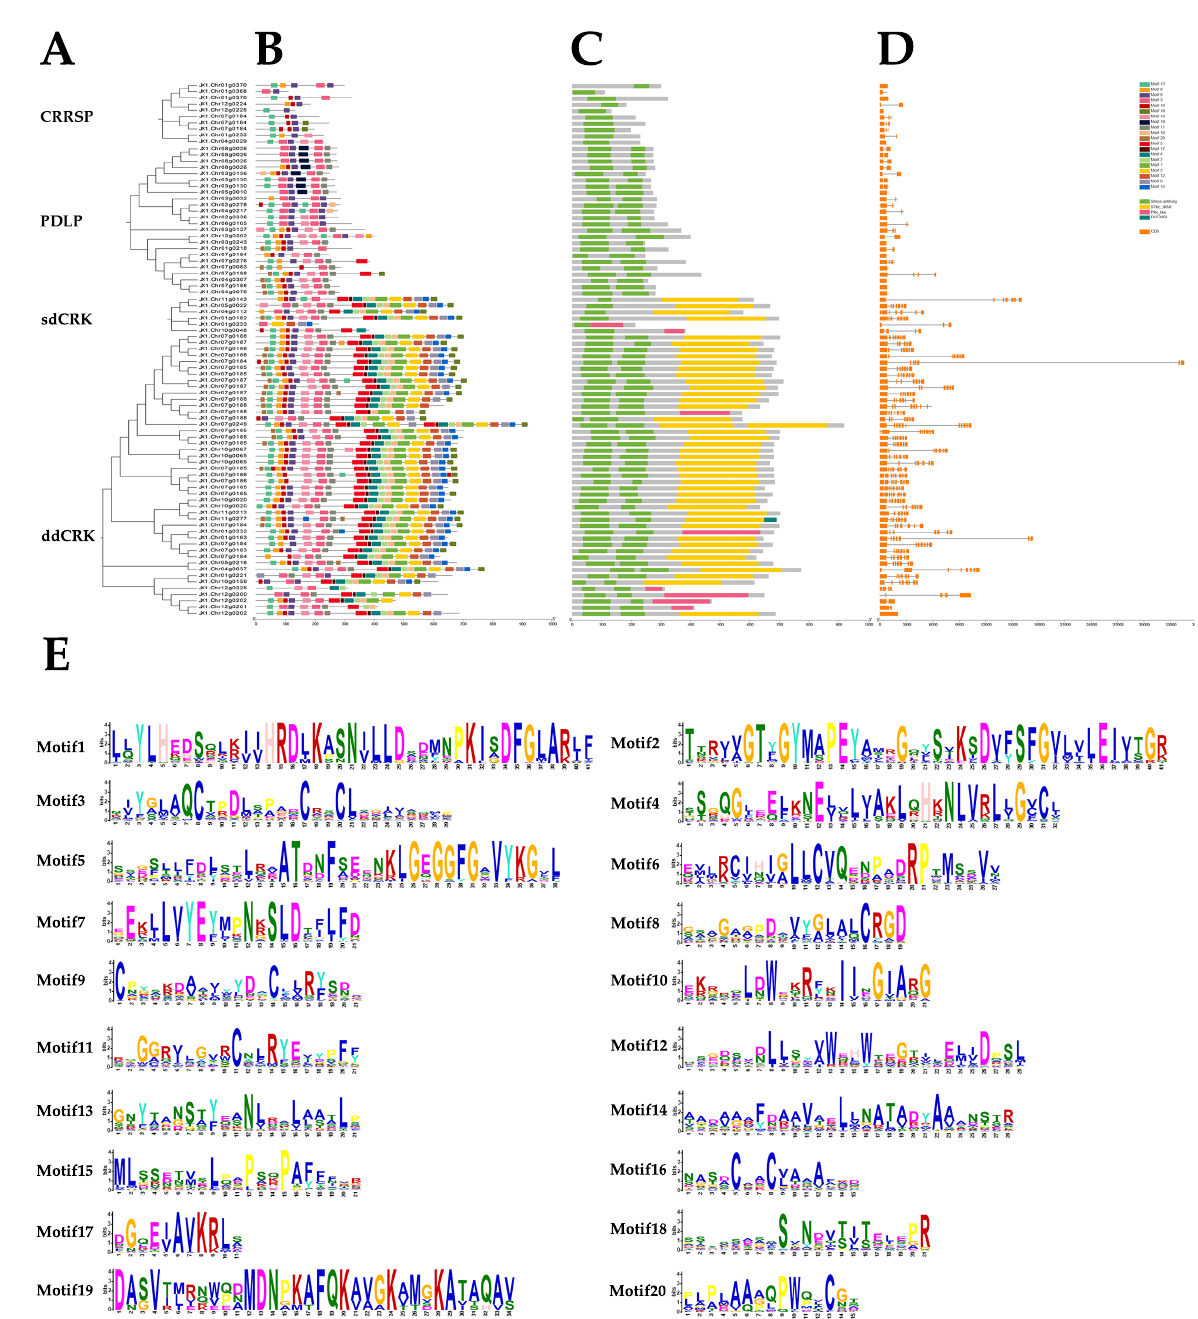
Figure 2. The phylogenetic relationship, structure, domain, and conserved motif analysis of DUF26 domain-containing genes in DXWR. ( A ) The phylogenetic tree was constructed based on the full- length sequences of DXWR DUF26 domain-containing proteins using MEGA12. ( B ) The distribution of motifs of the MAPK proteins. The conserved motifs of DUF26 domain-containing proteins were determined by MEME and visualized by TBtools. ( C ) Domain analysis of 85 DUF26 domain- containing proteins. Green represents DUF26 domain (stress antifung). Yellow represents the sTKc_IRAK kinase domain. Magenta represents the PKc_like domain. Blue green represents the duf3404 domain. ( D ) The exon–intron structures of the DUF26 domain-containing genes. Orange boxes indicate exons. ( E ) The sequence logo of the DUF26 domain-containing proteins motifs. The height of each amino acid represents the relative frequency of the amino acid at that